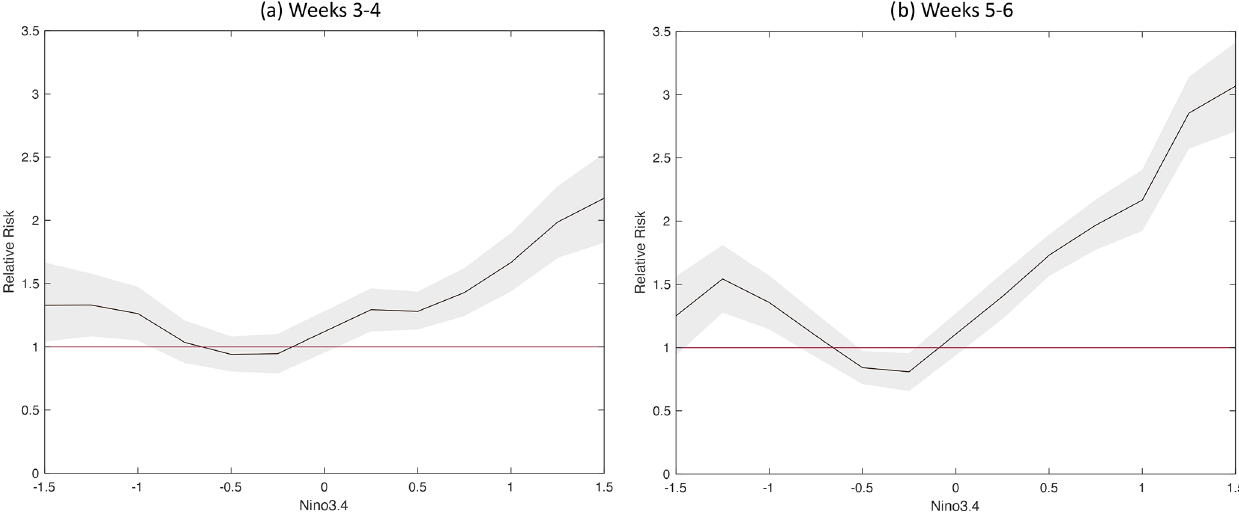
Figure 7. The black line shows the relative risk, relative to the risk on any given day, of an SFO, meaning one of the top 20% of expected-skill dates, occurring when the Niño3.4 index is greater than various thresholds, with 95% confidence intervals in gray